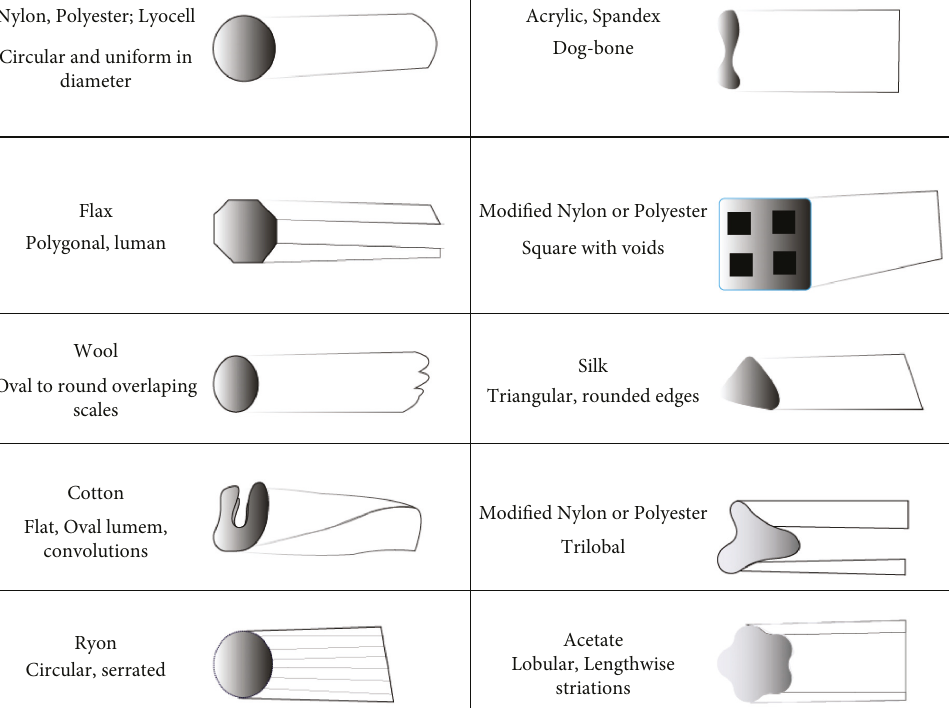
Figure 2: Cross-sectional shape of different fibers